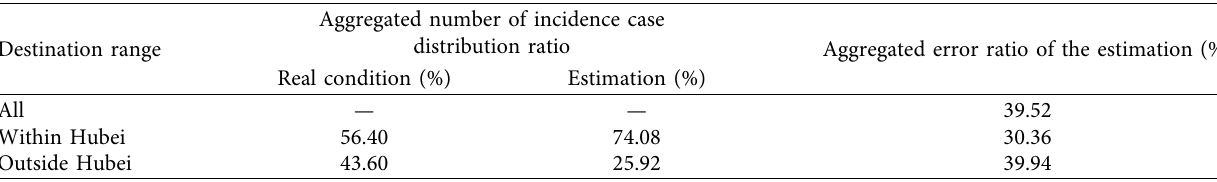
Table 11: Results of the aggregated number of incidence case distribution ratio and the aggregated error ratio of the number of estimated incidence case distribution for all destinations, destinations inside Hubei, and destinations outside Hubei.